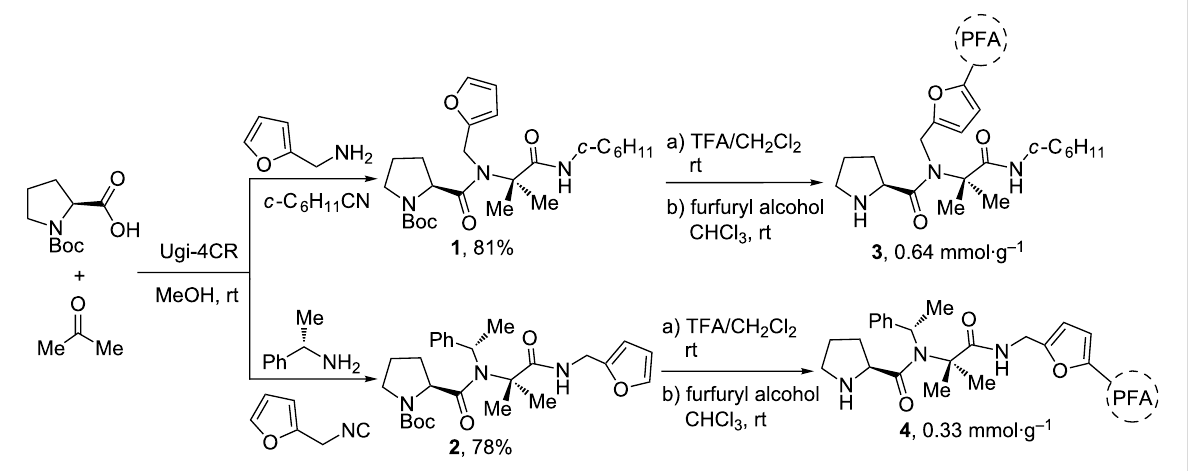
Scheme 2: Utilization of the Ugi four-component reaction (Ugi-4CR) for the synthesis of prolyl pseudo-peptide catalysts and their subsequent poly- merization with furfuryl alcohol leading to the organocatalytic polymers 3 and 4 . TFA = trifluoroacetic acid; PFA = polyfurfuryl alcohol.